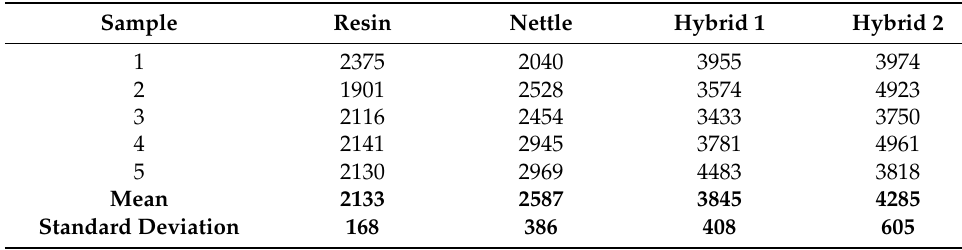
Figure 7. Variation of loss modulus with frequency.